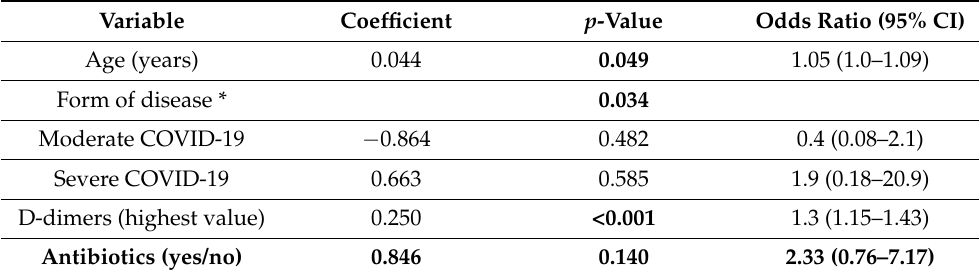
Figure 2. The Kaplan – Meier curves for the whole group ( a ) and subgroups (ATB and non-ATB) ( b ). Overall, the patients who received antibiotics during hospitalisation had a threefold higher mortality rate (12.5% vs 3.7%, RR = 3.37, p < 0.001). In a subgroup analysis, among the patients without reasons for prescription, those who received antibiotics had a sixfold greater risk of death, while among those with reasons, there was no difference regarding the outcome—both in bivariate analysis (Tables 3 and S1), and after adjusting for the other prognostic variables (Table 4). Table 4. The association of antibiotic treatments with death after adjustment for the prognostic factors (logistic regression).